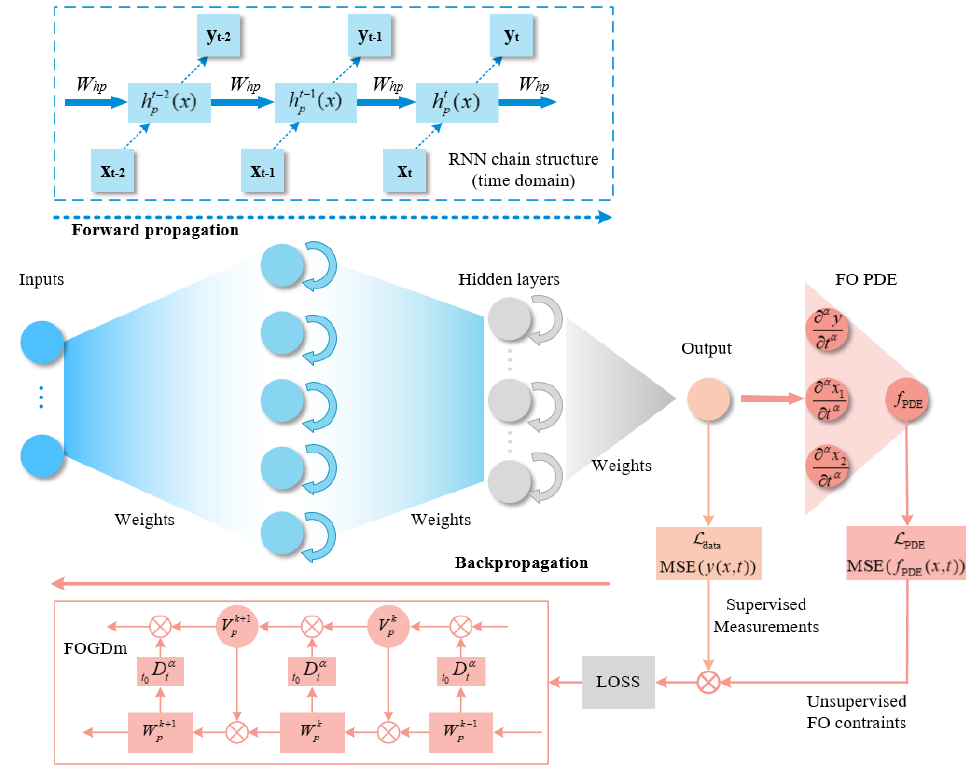
Figure 4. Framework of the proposed PIRNN with fractional-order constraints.